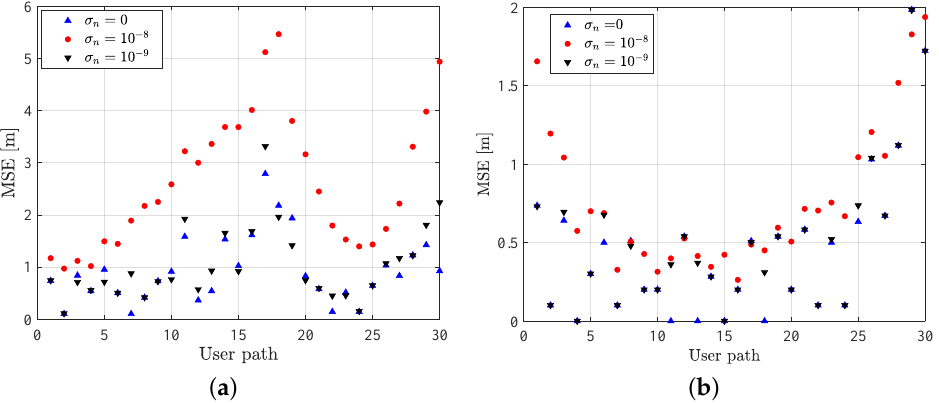
Figure 5. Comparison of MSE trends for different values of noise standard deviation computed for different user positions, for ( a ) variable and ( b ) fixed position along z -direction, i.e., z = 4 m.